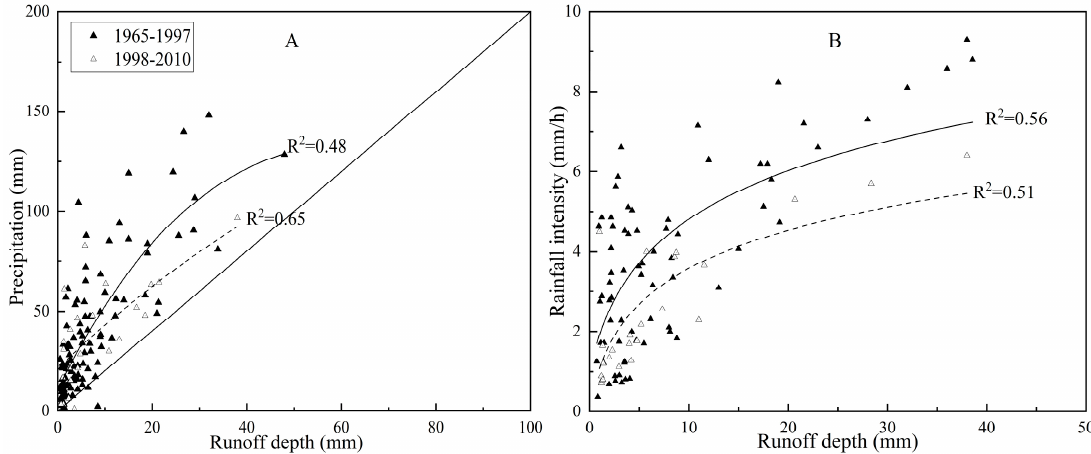
Figure 5. Correlation of runoff depth against precipitation ( A ) and rainfall intensity ( B ) in Gushanchuan Basin.